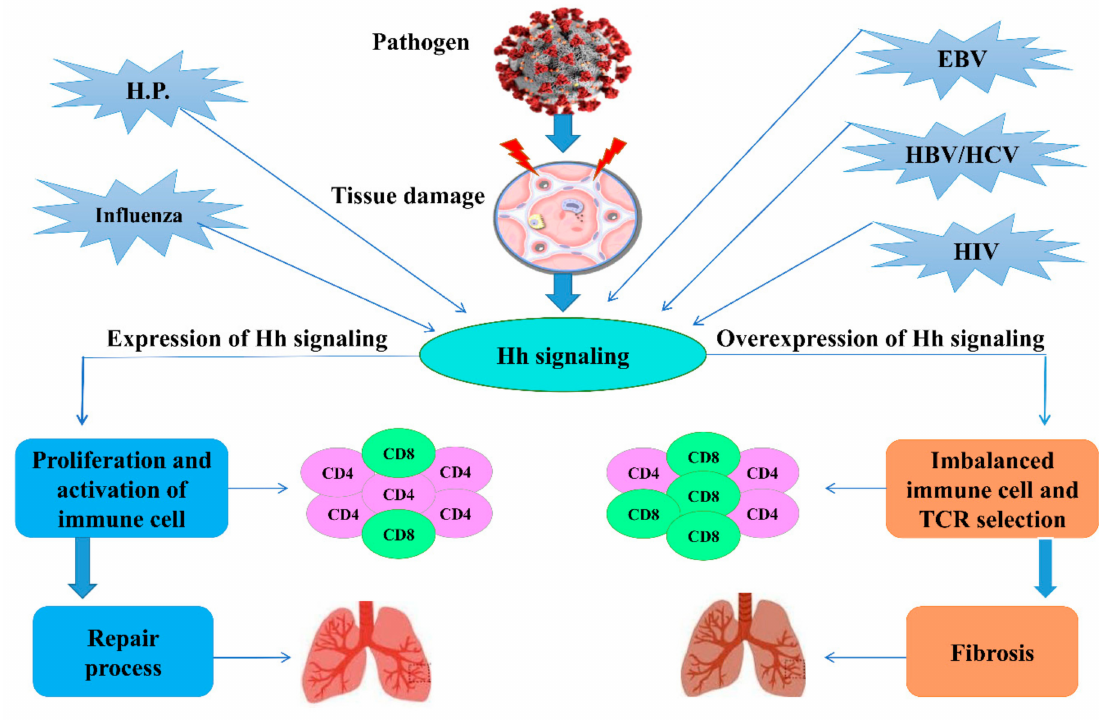
Figure 6. A proposed mechanism for what occurs during pathogenic and immune system interaction with the Hh signaling pathway. Pathogens become a cause to damage the host tissue and encourage the activation of the Hh signaling pathway. Pathogens play an essential role in immunity and the repair process due to key roles in. If Hh signaling is not regulated properly, it can cause fibrosis, immune cell imbalances, or T-cell receptors (TCR) selection. Pathogens such as Epstein–Barr Virus (EBV), Hepatitis B and C virus (HBV and HCV), Human Immunodeficiency Viruses (HIV), and Helicobacter Pylori (H.P.) have been shown to directly alter Hh pathway activity. Once Hh signaling is activated, it can aggravate or restrain these damaging